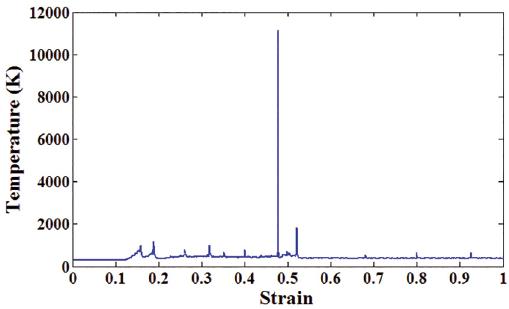
Figure 6: Temperature of a 30×50 Å 2 zigzag graphenylene versus strain